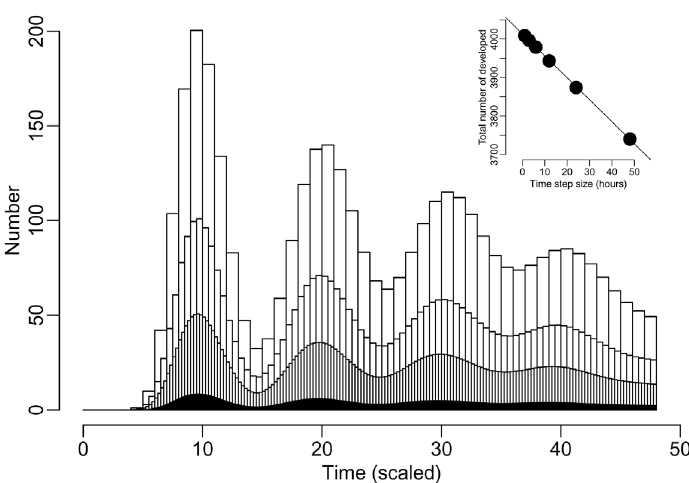
Figure 2. The effect of time step size to simulation accuracy. The number of individuals completing a development cycle is shown for different time steps. The widths of the bars correspond to the following time step sizes: 24 hours ( α = 1), 12 hours ( α = 2), 6 hours ( α = 4), and 1 hour ( α = 24) from the widest to the thinnest. The inset graph shows the total number of developed individuals with respect to different step sizes (solid dots). The line of best fit is also shown in the